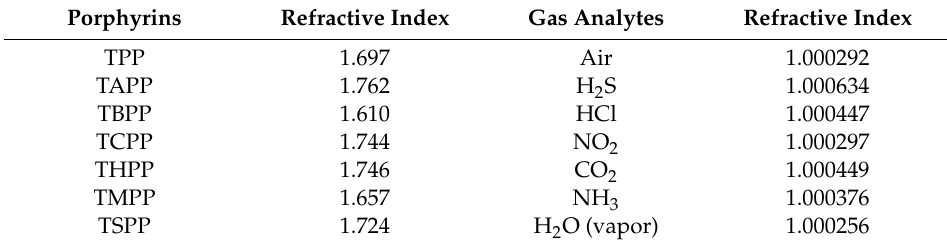
Figure 2. Schematic diagram of the homemade optical waveguide (OWG) detecting system. Table 1. Refractive indexes (589.3 nm) of porphyrin and analyte gases (101,325 Pa, 298 K)